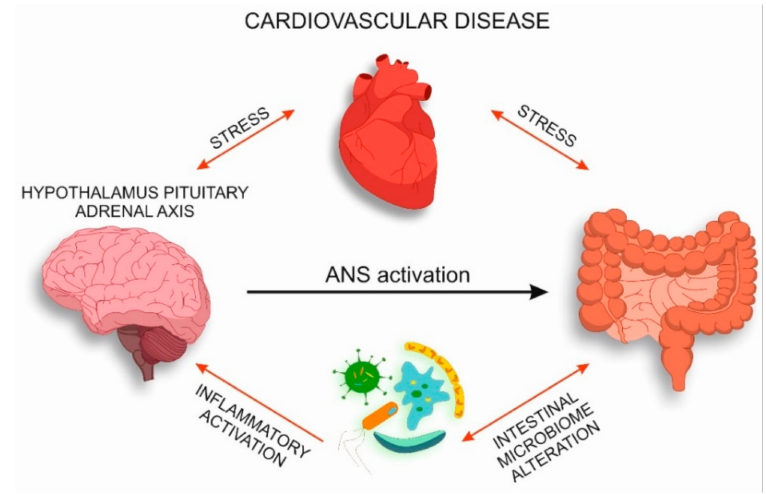
Figure 2. Interaction of intestinal microbiota and nervous system in